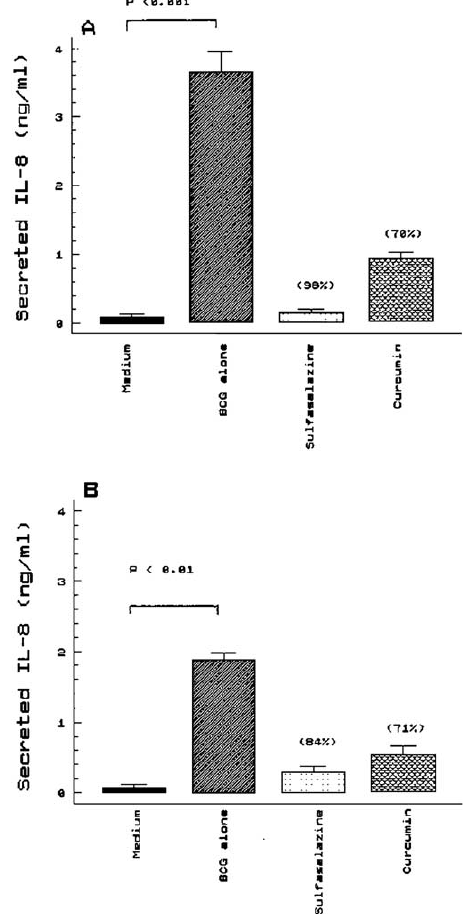
FIG. 1. Effect of NF- k B on M. bovis-induced IL-8 secretion from U937 cells and HEp-2 cells. U937 cells (A) or HEp-2 cells (B) were incubated with medium alone, or treated with sulfasalazine (2 mM) or curcumin (20 mM) prior to infection with M.bovis. Following further culturing for 48 h, the cell culture supernatants were harvested and the IL-8 protein was measured by ELISA. The mean and standard deviation of triplicate experiments are shown in each graph. Results in parentheses indicate the percentage of inhibition with respect to BCG cultures.